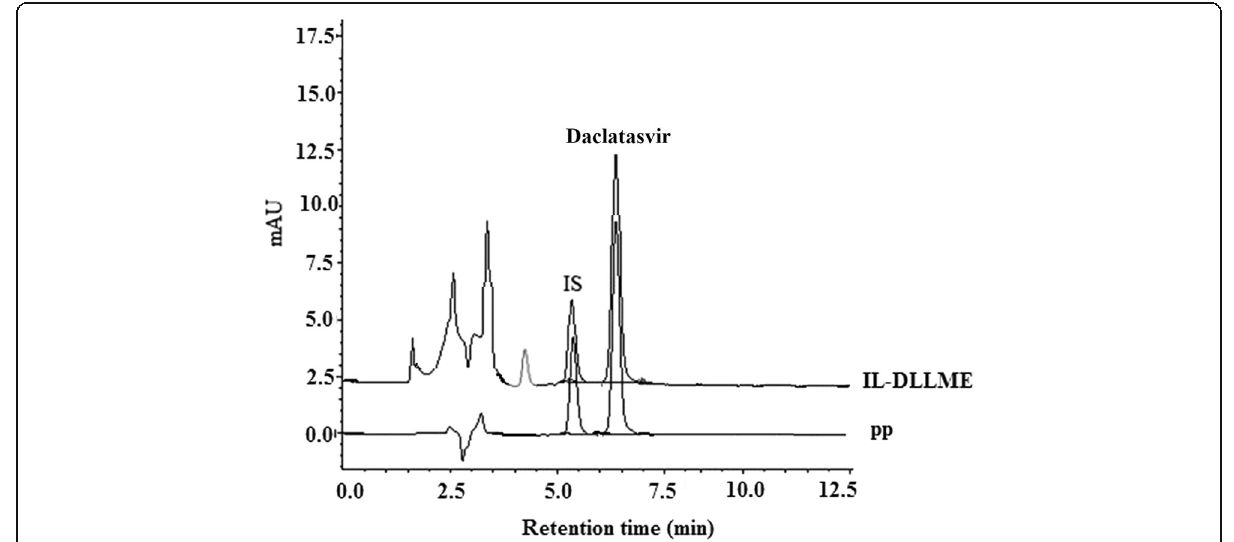
Fig. 5 Typical representative chromatograms of protein precipitation (PP) and IL-DLLLME extracts of daclatasvir from rat serum